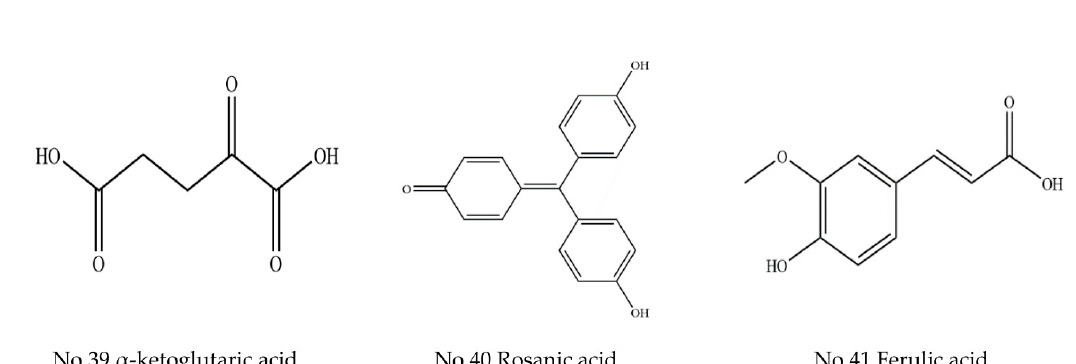
Figure 2. The structures of Polyphenols, Flavonoids, Triterpenoids, Sesquiterpenes, Saponins, and Organic acids in Loquat leaves.